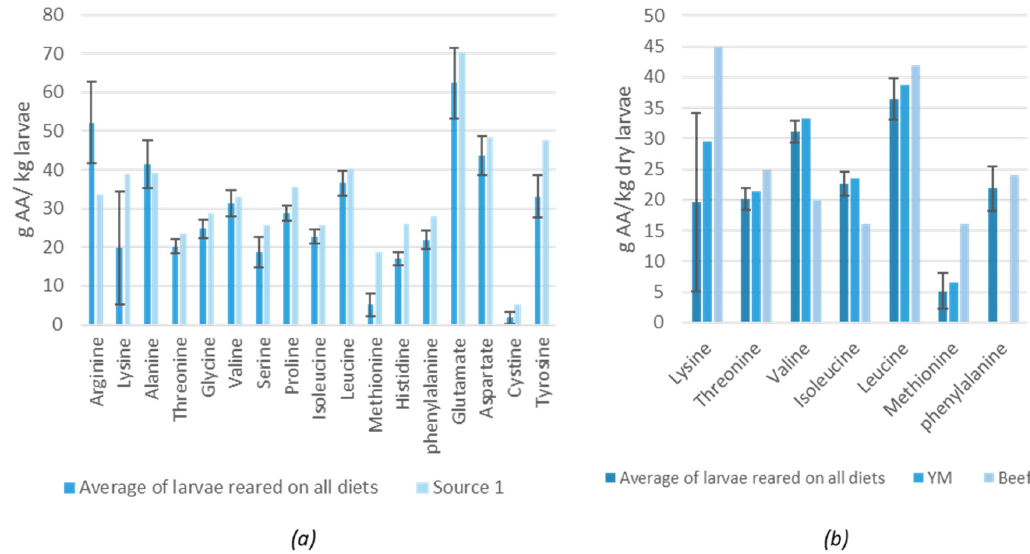
Figure 3. ( a) Average amino acid profile of lesser mealworm (LM) larvae reared on the diets in the current study compared to data found in literature (Source 1: [19]). ( b ) Comparison of the essential amino acids in LM larvae (measured in the current study) with yellow mealworm (YM) larvae [27] and beef [3], AA = amino acid, YM = yellow